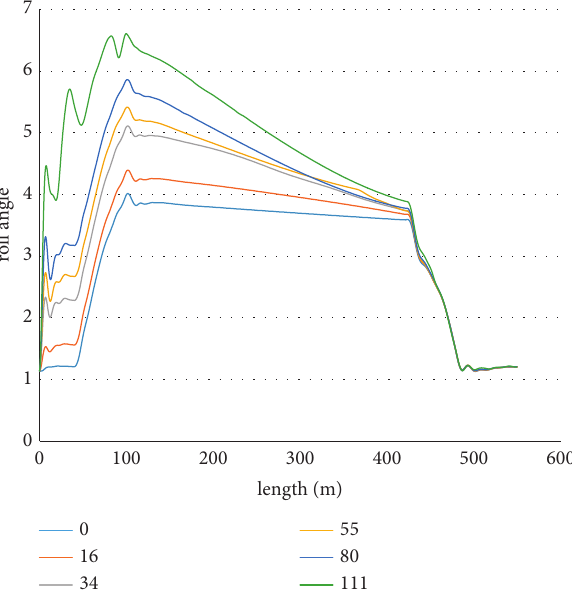
Figure 17: Comparison of overturning angle along the path at different wind